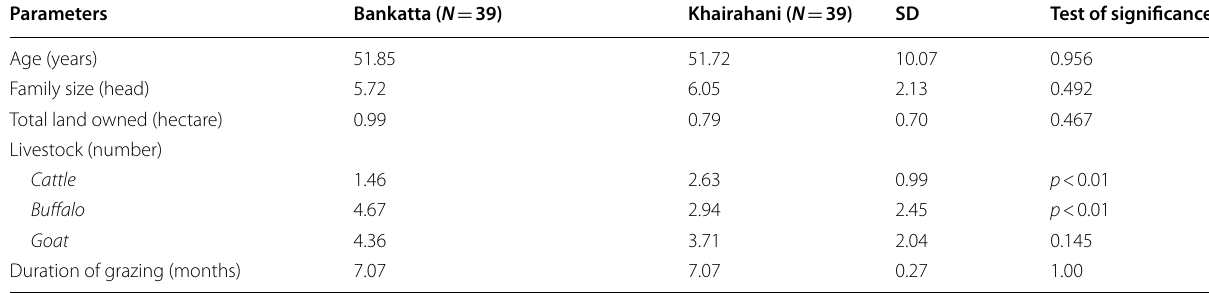
p -value estimated by log transformation of data N number of respondents, SD standard deviation